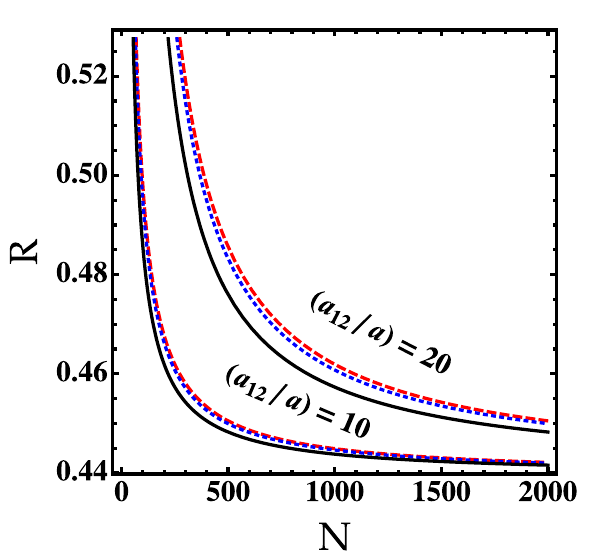
Figure 5. ( a ) Density profiles of the self-bound droplet obtained from the numerical solution of Eq. (15) at zero temperature for N = 1000 atoms and ln ( a 12 / a ) = 20 . ( b ) Density profiles of the self-bound droplet obtained at different values of temperature for N = 1000 atoms and ln ( a 12 / a ) = 20 . Solid line: T = 0 . Dashed line: T = 0.18 T BKT . Dotted line: T = 0.3 T BKT . Dotted-Dashed line: T = 0.4 T BKT .